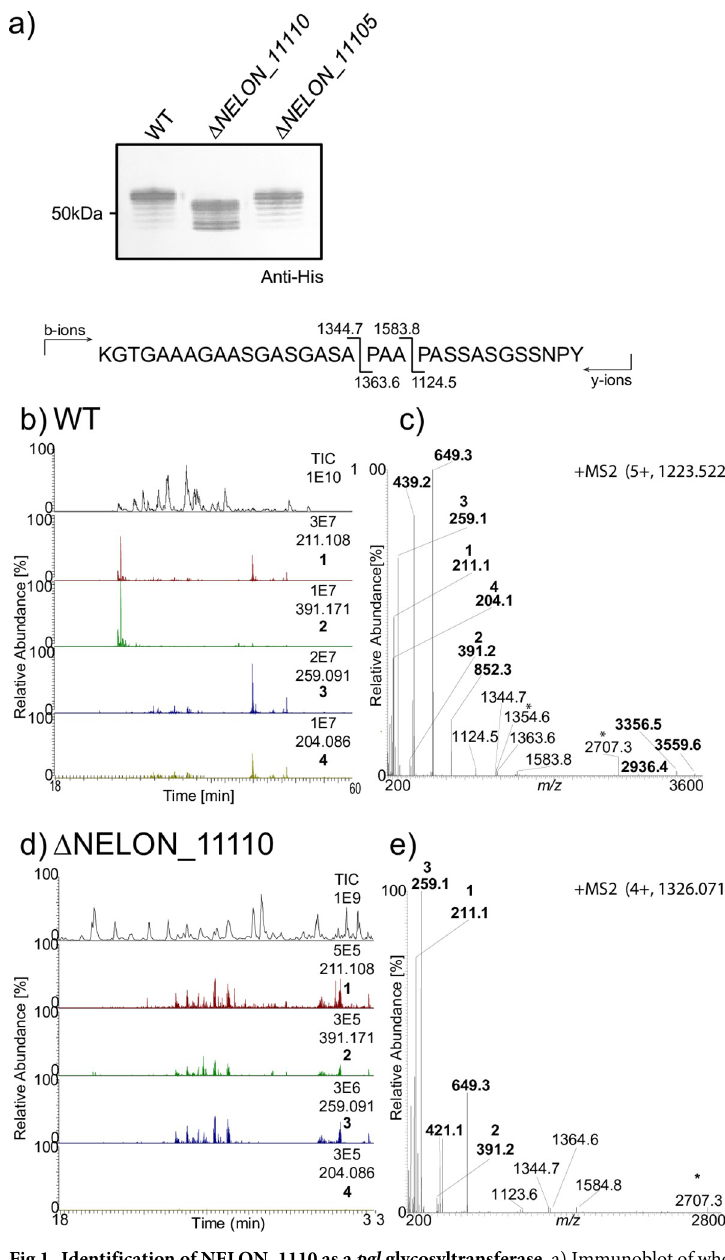
Fig 1. Identification of NELON_1110 as a pgl glycosyltransferase. a) Immunoblot of whole-cell lysates from strains expressing NirK-His6x using the wild type (WT, KS992), Δ NELON_11110 (KS1032) and Δ NELON_11105 (NW270) strains (S1 Fig, S1 Table) using a tetra-His epitope recognizing antibody. Multiple isoforms of NirK-His are the result of macroheterogeneity (variable glycan site occupancy) as NirK has five potential sites of glycan addition. b-e) Liquid chromatography tandem MS (LC-MS2) chromatograms of the peptide shown from affinity purified NirK from WT and a Δ NELON_11110 mutant. Total ion chromatogram (TIC) intensity values represents amounts of peptides entering the mass spectrometer. The selected ion chromatograms (SIC) are of the four glycan reporter ions characteristic for a tetrasaccharide; diNAcBac at m/z 211.108 (1), diNAcBac-Hex at m/z 391.170 (2), diNAcHexA at m/ z 259.093 (3) and HexNAc at m/z 204.086 (4). The MS2 spectrum demonstrates the presence of glycan reporter ions (marked in bold and numbered as defined above). b) The LC-MS2 chromatogram of the NirK derived peptide from a WT background. c) MS2 spectrum of the peptide from a WT (in panel b) background bearing a diNacBac-Hex- diNAcHexA-HexNAc tetrasaccharide. d) The LC-MS2 chromatogram the peptide from the Δ NELON_11110 background. e) MS2 spectrum of the peptide Δ NELON_11110 background (panel d) carrying the diNacBac-Hex- diNAcHexA trisaccharide.